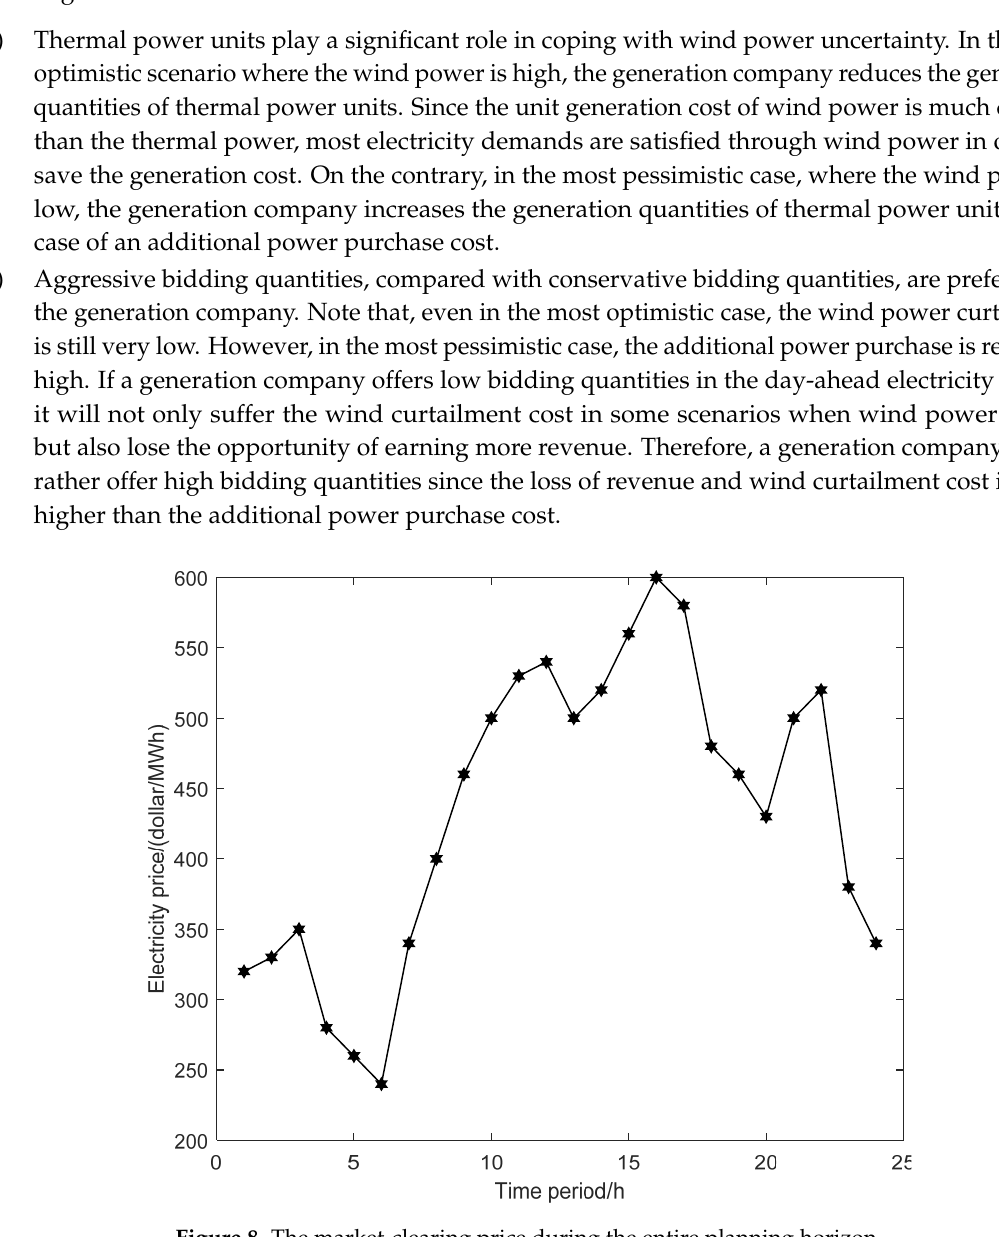
Figure 8. The market ‐ clearing price during the entire planning horizon.